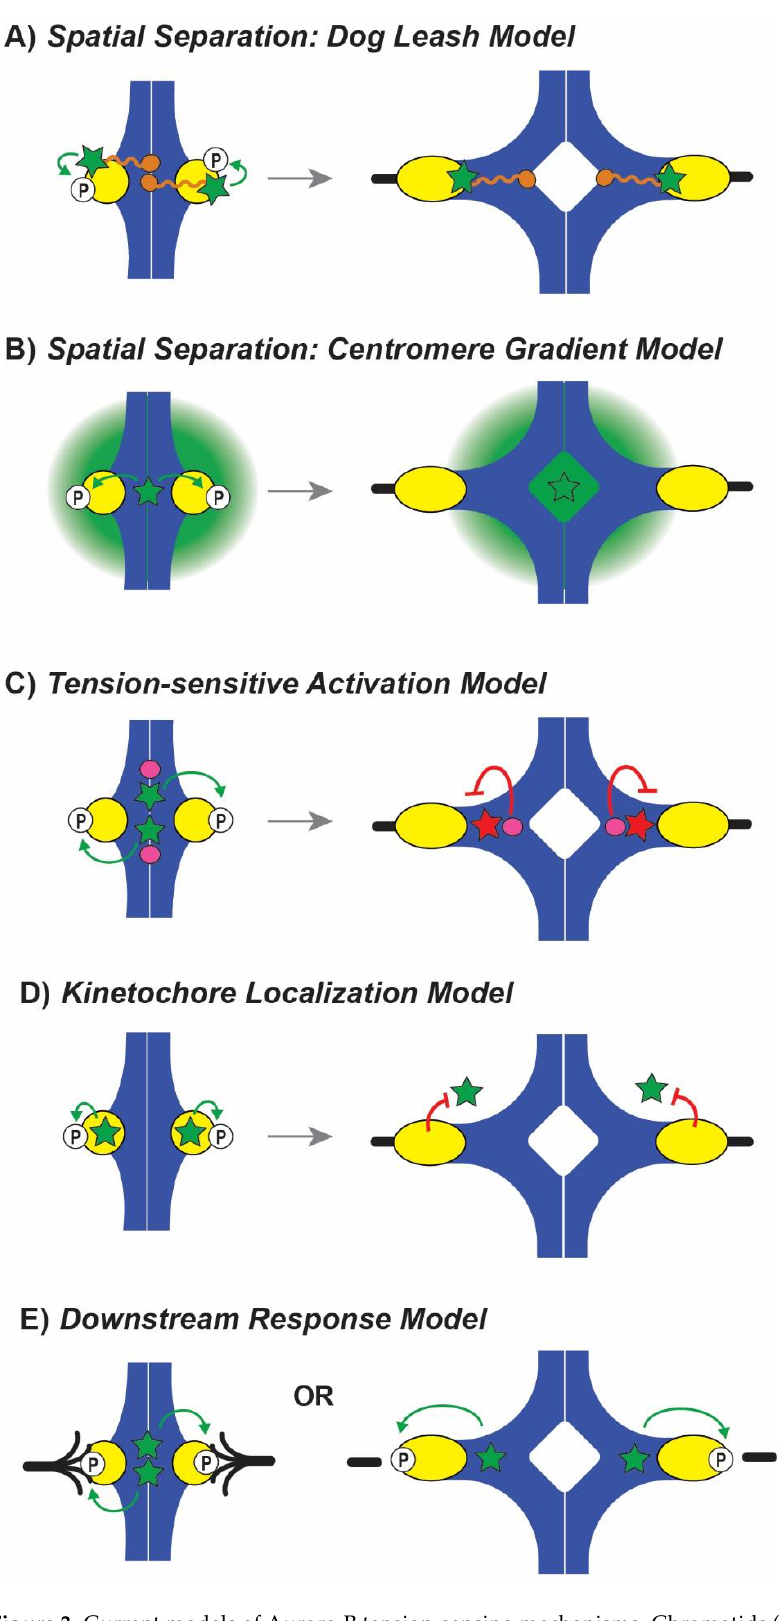
Figure 3. Current models of Aurora-B tension-sensing mechanisms. Chromatids (blue) and bound by kinetochores (yellow) are regulated by Aurora B (star) based on tension. Attachments to